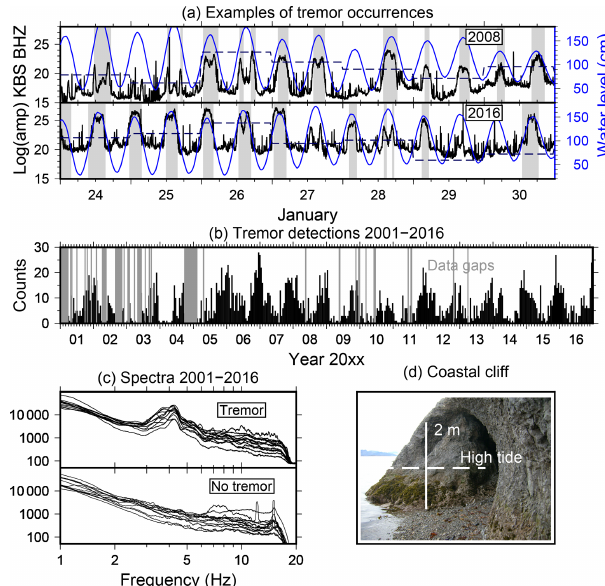
Figure 5. Repeating seismic tremor measured at KBS. (a) Tempo- ral distribution of spectral amplitude between 3.4 and 5.7Hz and water level (chart datum) at the end of January in 2008 and 2016. The high spectral power lasting several hours are tremor time pe- riods which correlate with ocean tides. Gray areas indicate auto- matic tremor detections. Horizontal dashed lines show the relative change in daily wind speed. (b) Temporal distribution of seismic tremor detections (counts in 2 weeks). (c) Monthly averaged ampli- tude spectra of seismic tremor detections (vertical component) and of a selection of monthly time periods without tremors (2016